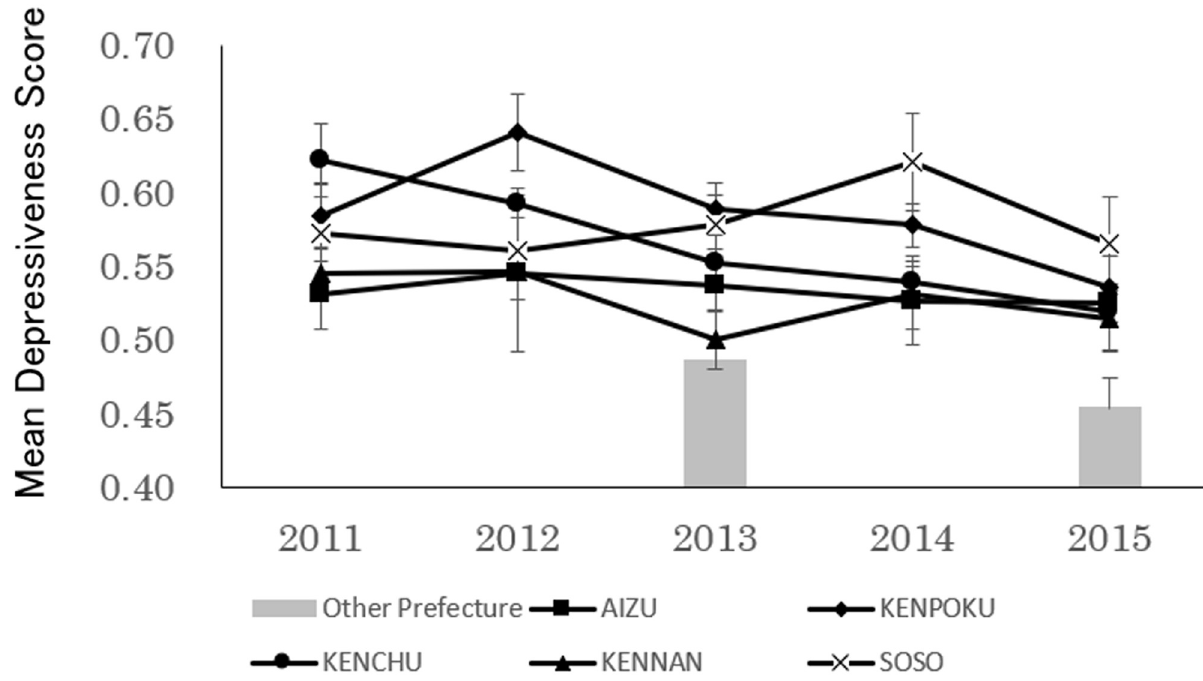
Fig 4. Transition over time in depressiveness (Mean ± SE) of 18 and 42-month-old children residing in low-contamination regions.